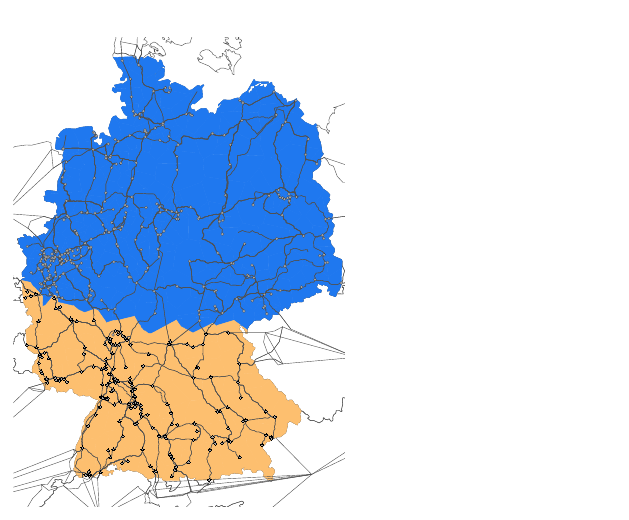
Figure 2. Delimination of the German price zone as applied for the investigation of the SPLIT case. Source: [28].